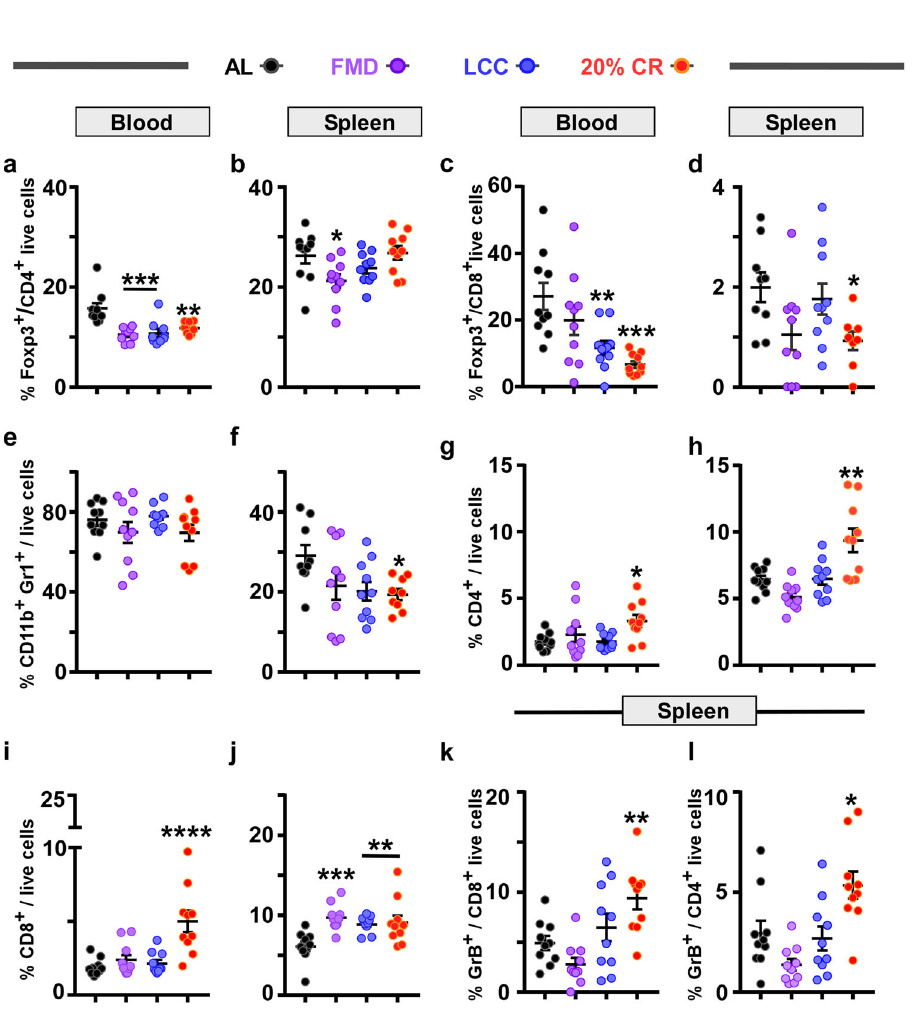
Fig. 6 Daily CR leads to a unique immune pro fi le in response to 4T1 tumor burden. Percentage of immune cells detected in the peripheral blood ( a , c , e , g , i ) and spleen ( b , d , f , h , j ). a, b Foxp3 + CD4 + T regulatory cells; c, d Foxp3 + CD8 + T regulatory cells; e, f CD11b + Gr1 + cells (MDSCs); g, h effector CD4 + cells; i, j effector CD8 + cells. k Percentage of GrB + CD8 + cells and l GrB + CD4 + cells in the spleen. The data is represented as scatter plots showing mean values±SEM. One-way ANOVA with Tukey post hoc analysis was used to determine statistical signi fi cance with * p <0.05, ** p <0.01, *** p <0.001, **** p <0.0001 compared to AL. a AL, n = 10; FMD, n = 9; LCC, n = 10; CR, n = 10. b , c , e , g-l AL, n = 10; FMD, n = 10; LCC, n = 10; CR, n = 10. d AL, n = 9; FMD, n = 10; LCC, n = 10; CR, n